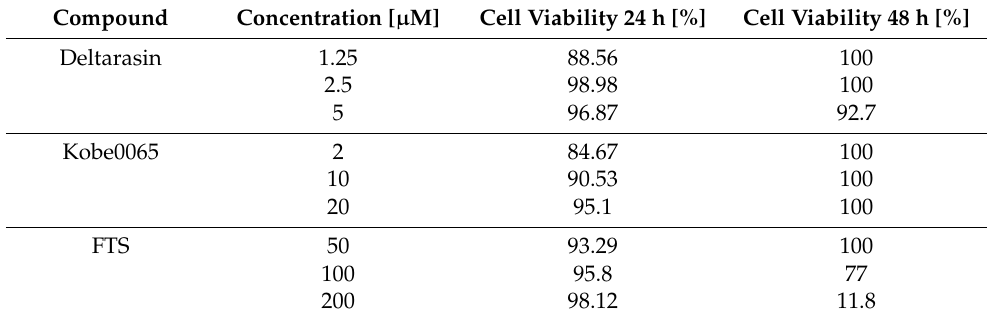
Table 2. The effects of FTS, Kobe0065 and deltarasin on A549 lung cancer cell viability incubated with the indicated concentrations of compounds for 24 and 48 h, assessed by MTT assay.